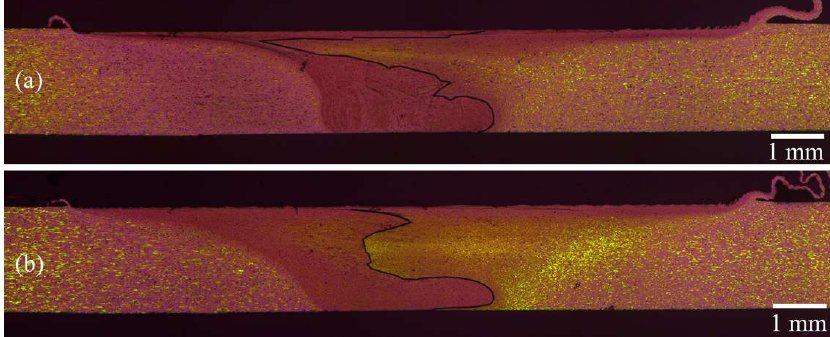
Figure 14. Cross sections of ( a ) FSW-WS = 3-AA2024-P and ( b ) FSW-WS = 3-AA2024-R.